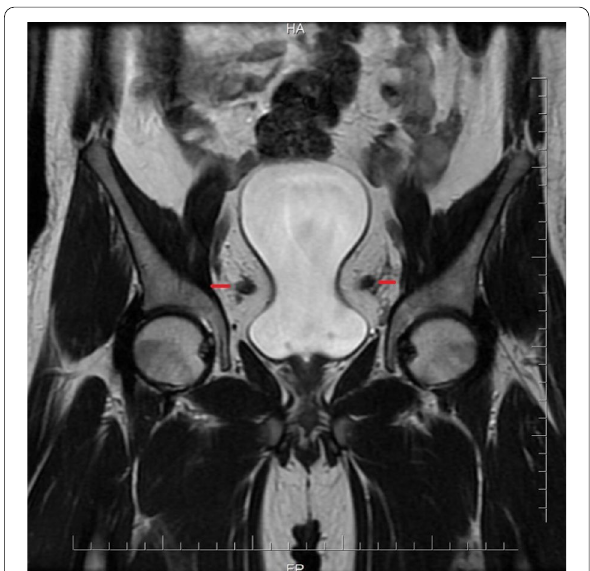
Fig. 2 Coronal MRI pelvis showing ‘Donald duck’ appearance with pelvic lipomatosis compressing the bladder and ‘eye’ formed by dilated